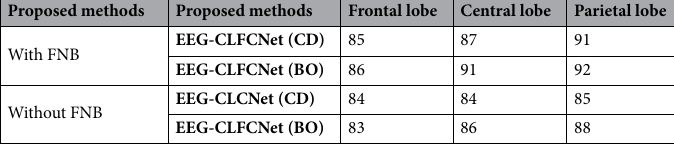
Table 4. Average accuracy of three brain regions with proposed methods.